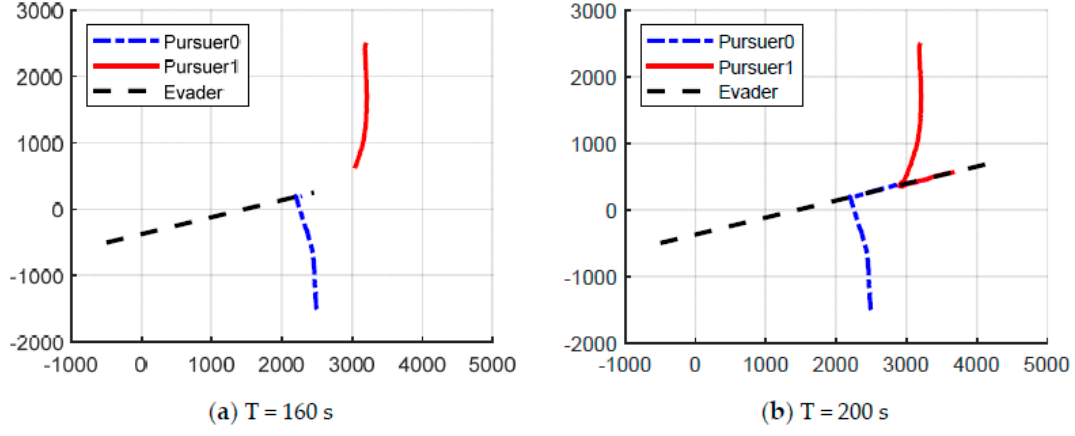
Figure 12. The traces of P 0 , P 1 and E 0 under the proposed SK-FACL with ∆ v = 30% v P